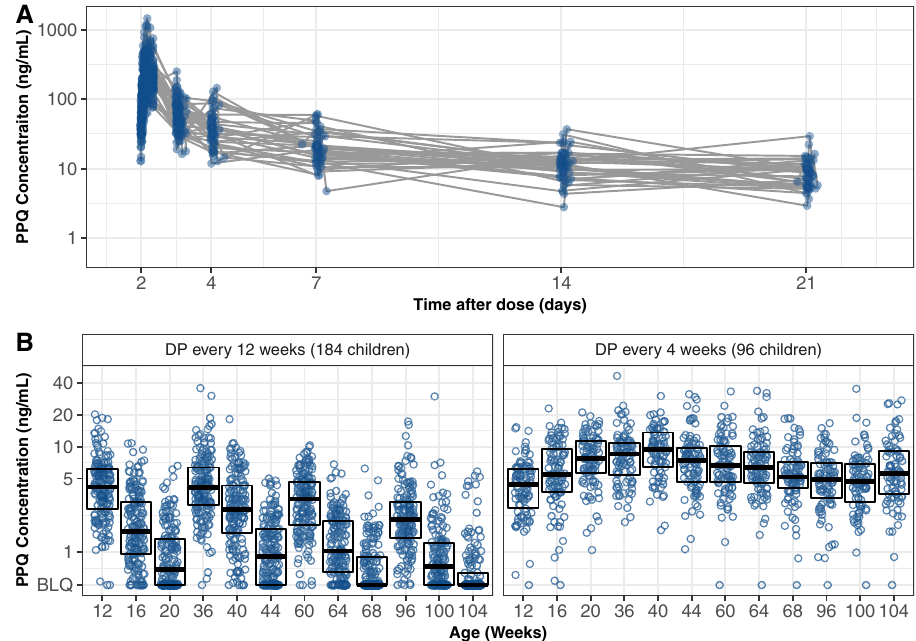
Fig. 3 Raw pharmacokinetic data. A Piperaquine (PPQ) concentration from intensive sampling after the third daily dihydroartemisinin-piperaquine (DP) dose (day 2) for 32 children at 32 and 104 weeks of age. B PPQ concentrations from sparse sampling obtained from 280 children at 28-days intervals. Boxes indicate PPQ levels for 25% (minima), 50% (center), and 75% (maxima) of the